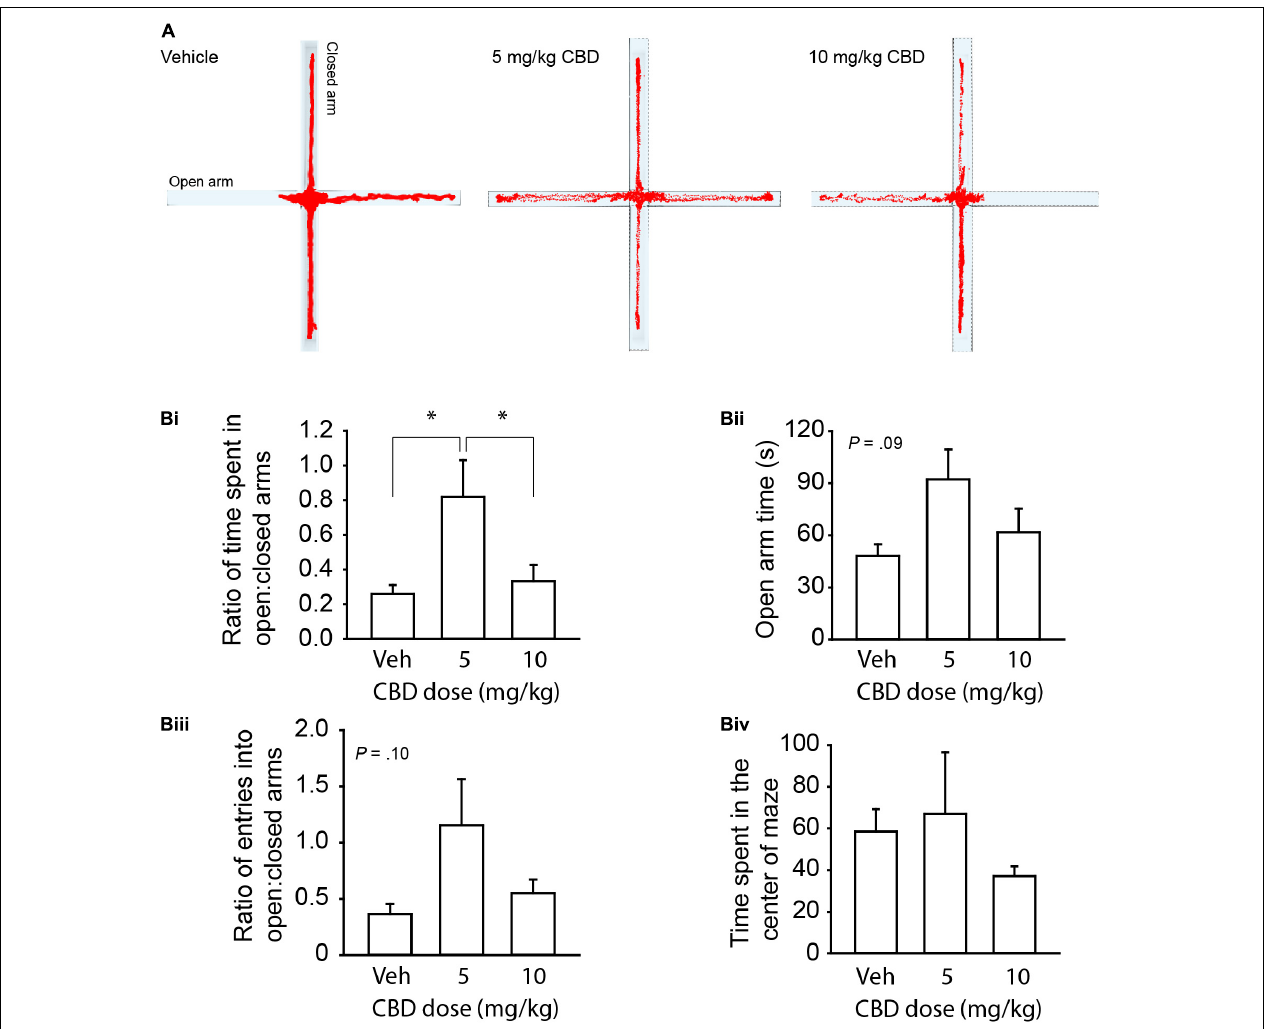
FIGURE 1 | CBD dose dependently reduces anxiety-like behavior on the EPM in adult mice. (A) Representative activity traces of subjects administered vehicle, 5 mg/kg CBD, and 10 mg/kg CBD. (Bi) Summary bar chart showing that 5 mg/kg CBD increased the ratio (left) of time spent in the open arm relative to the closed arm (0.82 ± 0.21, n = 6) compared to vehicle (0.26 ± 0.05, n = 6) and 10 mg/kg (0.33 ± 0.10, n = 6) treated mice. (Bii) Summary bar chart showing the trend ( P = 0.09) for CBD to affect time spent in the open arms by one-way ANOVA. 5 mg/kg treated mice spent more time in the open arm (92.10 ± 17.31 s) compared to vehicle (48.00 ± 6.78 s) and 10 mg/kg (61.8 ± 13.68 s) treated mice. (Biii) Summary bar chart showing a trend ( P = 0.10) for CBD to affect the ratio of entries into the open:closed arms of the EPM by one-way ANOVA. 5 mg/kg treated mice had a higher ratio of entries into the open arms compared to the closed arms (1.16 ± 0.41) compared to vehicle (0.37 ± 0.09) and 10 mg/kg (0.55 ± 0.12) treated mice. (Biv) Summary bar chart showing that there were no differences between treatment groups in time spent in the center square of the EPM. ∗ indicates P < 0.05 by Tukey’s HSD post hoc